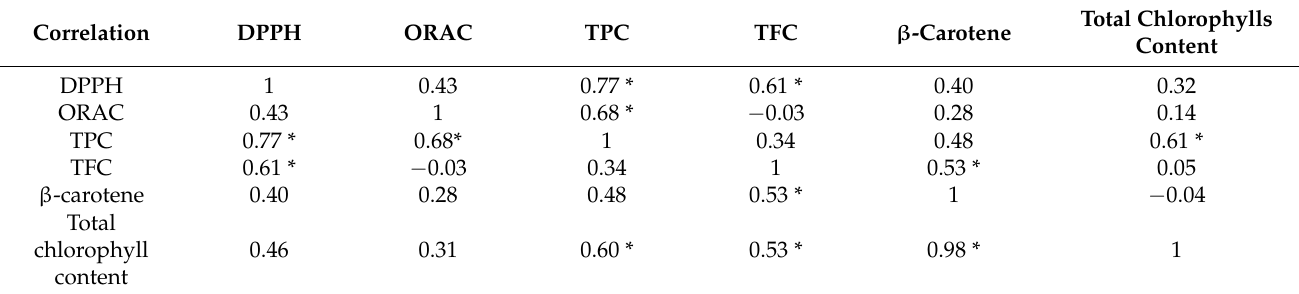
Table 2. Correlation coefficients (r) calculated for the relationships between (r marked by * are statistically significant at p <